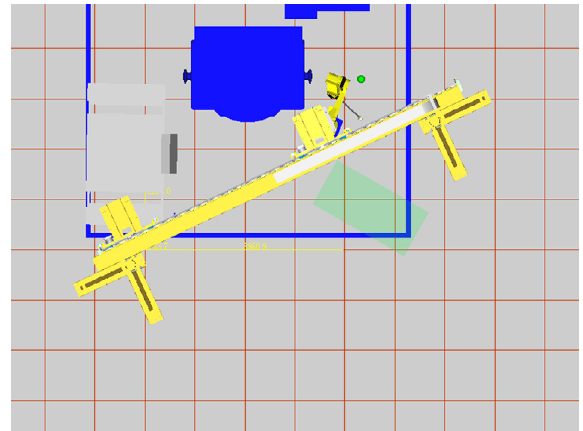
Figure 14. Checking clearance of robot and park position.